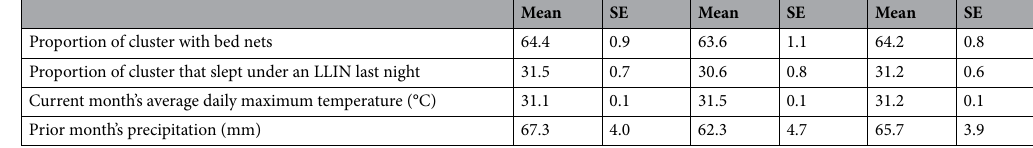
Table 1. Characteristics of the study population, stratified by P. falciparum PCR status, 2015–2016 Malawi Demographic and Health Survey. *Counts do not incorporate sample weights, and are not representative of the weighted populations used in the table. **Sampling weights applied. LLIN long-lasting insecticide-treated net.